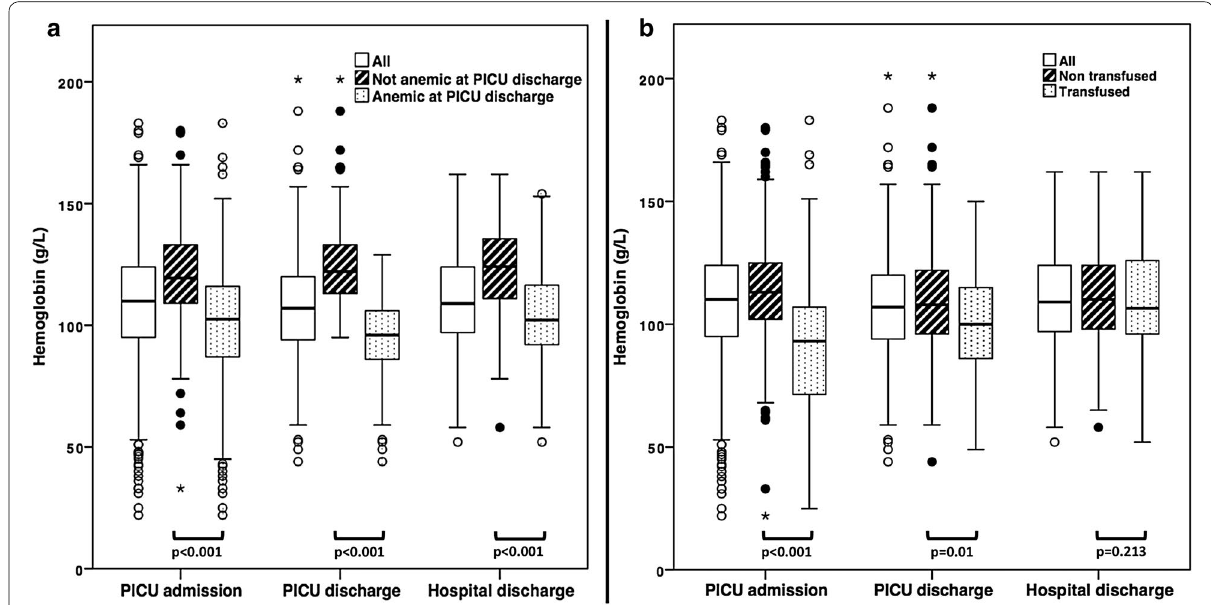
Fig. 2 Whisker plots of the hemoglobin level at PICU admission, PICU discharge and hospital discharge for children anemic and non-anemic at PICU admission ( a ) and for children transfused and non-transfused during their PICU stay ( b ). PICU pediatric intensive care unit; points and asterisks represent outliers and extreme outliers, respectively